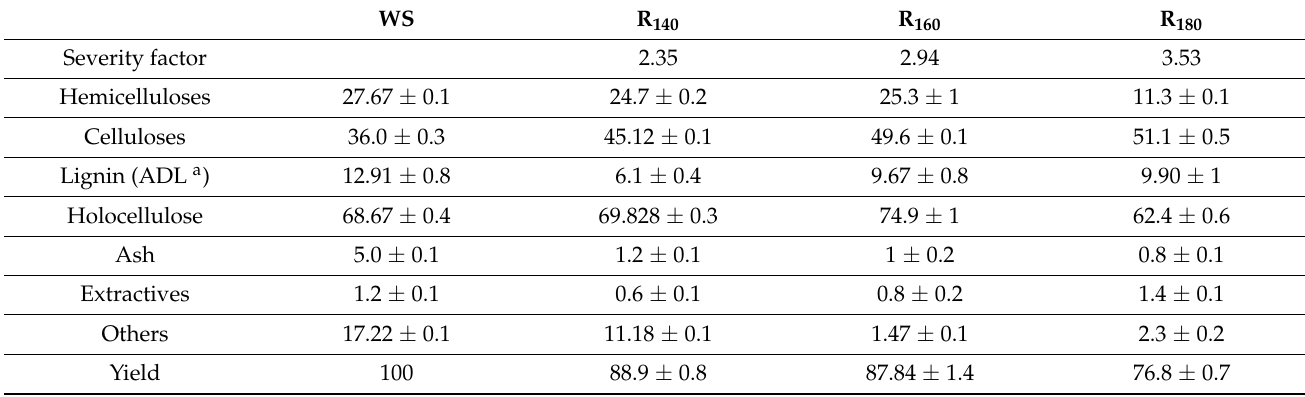
Table 1. Chemical composition (% DM) of the raw material (WS) and pre-treated residues after the hydrothermal pretreatment.